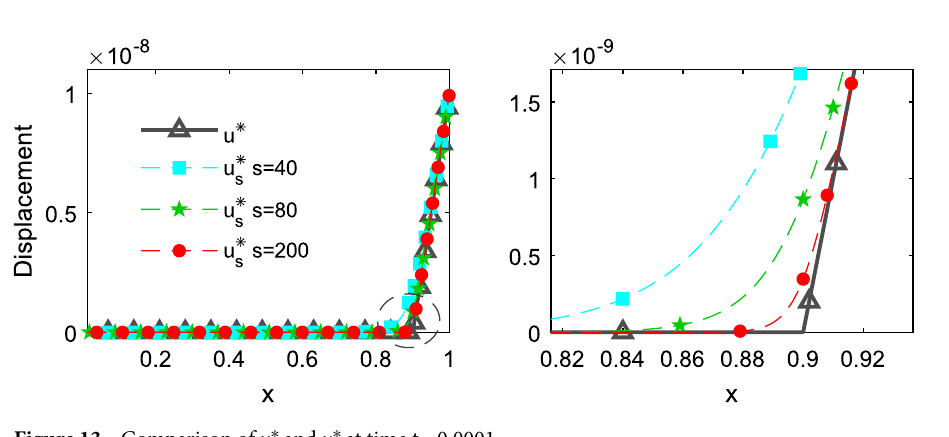
Figure 13. Comparison of u ∗ and u ∗ s at time t =